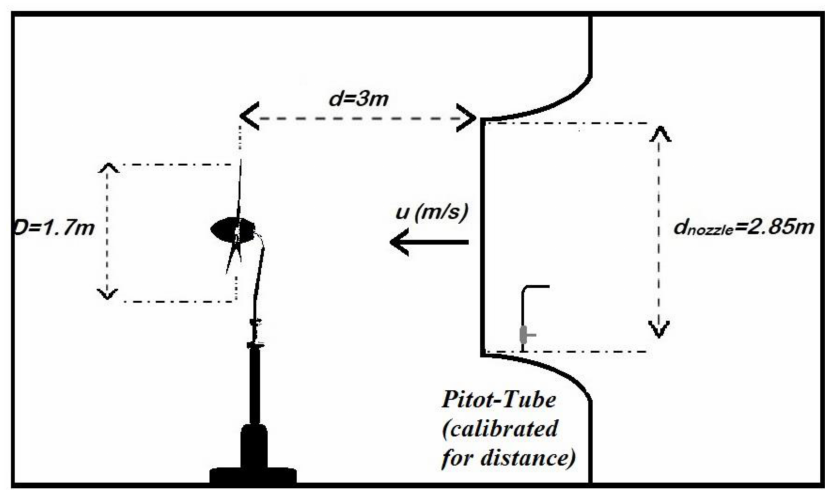
Figure 2. Diagram of installation of micro wind turbine in the Open Jet Facility (OJF) and wind speed pitot-tube.